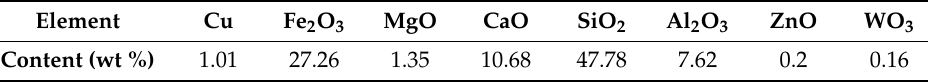
Table 1. Elemental composition of copper ore used in this